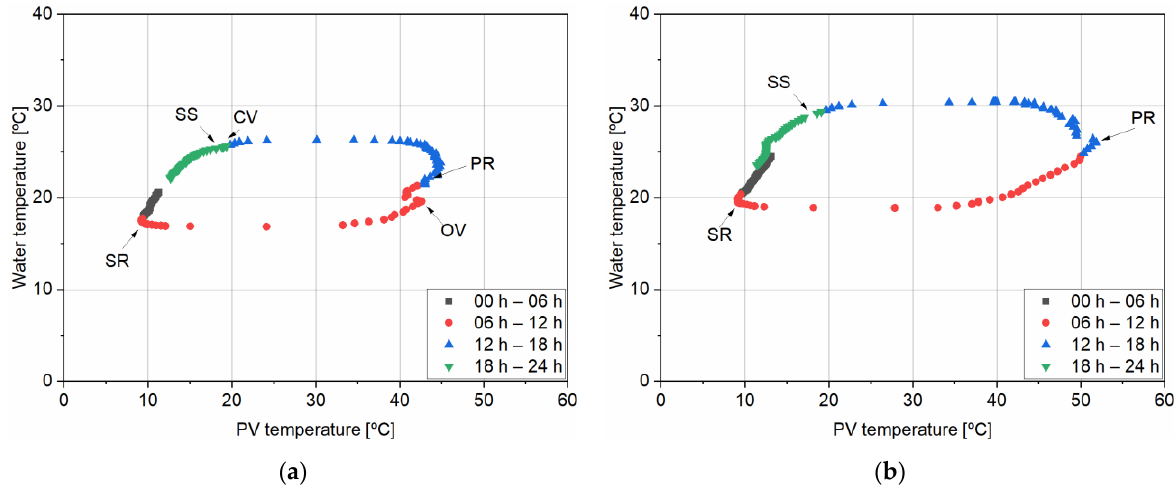
Figure 9. BIPV-WS water thermal behavior: ( a ) February 21st, ventilated air cavity; ( b ) February 24th, non-ventilated air